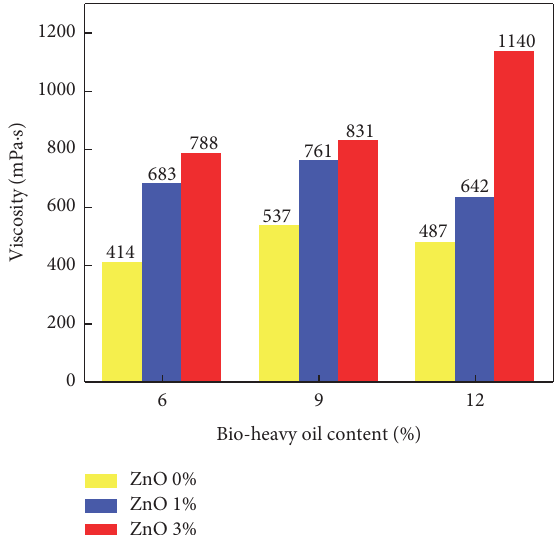
Figure 9: Dynamic viscosity of three kinds of asphalt.